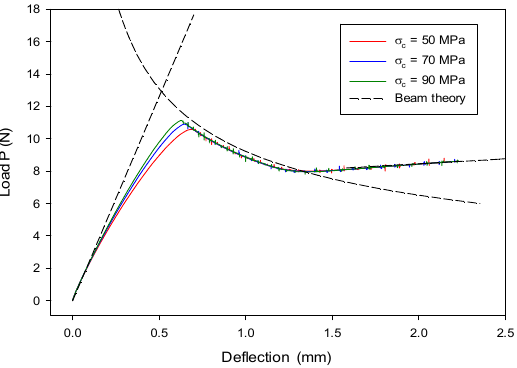
0.0 Deflection (mm) Figure 23. End load P as a function of deflection ∆ in the MMB model ( β = 20%) with different Figure 23. End load P as a function of deflection ∆ in the MMB model ( β (cid:3404) 20%) with different cohesive strengths. cohesive